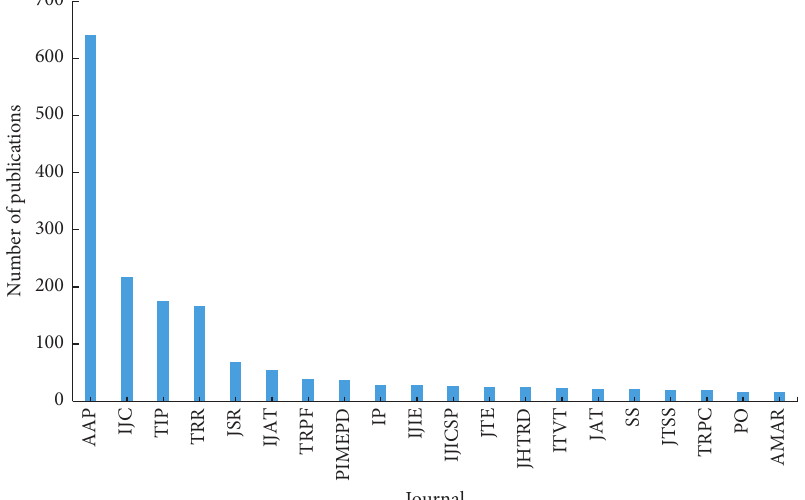
Figure 3: Number of publications from different journals. Note: AAP is Accident Analysis & Prevention; IJC is International Journal of Crashworthiness; TIP is Traffic Injury Prevention; TRR is Transportation Research Record; JSR is Journal of Safety Research, IJAT is International Journal of Automotive Technology; TRPF is Transportation Research Part F: Traffic Psychology and Behavior; PIMEPD is Proceedings of the Institution of Mechanical Engineers, Part D: Journal of Automobile Engineering; IP is Injury Prevention; IJIE is International Journal of Impact Engineering; IJICSP is International Journal of Injury Control and Safety Promotion; JTE is Journal of Transportation Engineering; JHTRD is Journal of Highway and Transportation Research and Development; ITVT is IEEE Transactions on Vehicular Technology; JATis Journal of Advanced Transportation; SS is Safety Science; JTSS is Journal of Transportation Safety & Security; TRPC is Transportation Research Part C: Emerging Technologies; PO is PLOS One; AMAR is Analytic Methods in Accident